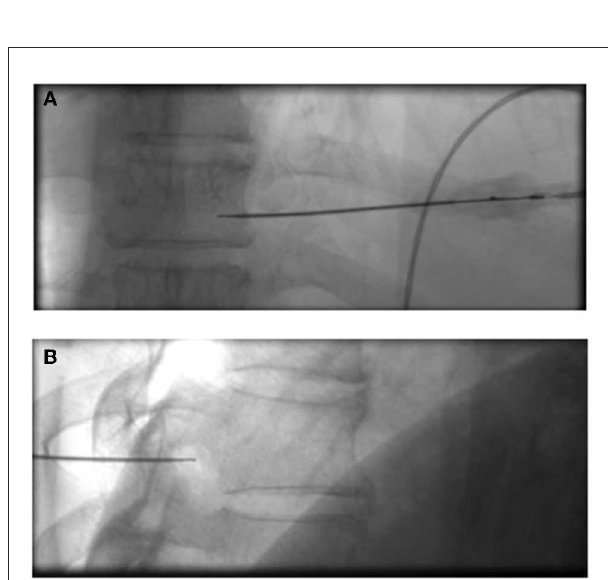
FIGURE4 Insertion and position of the plasma knife. In the positive (A) and lateral position (B) , confirm that the target point of the plasma knife head reaches the dorsal root